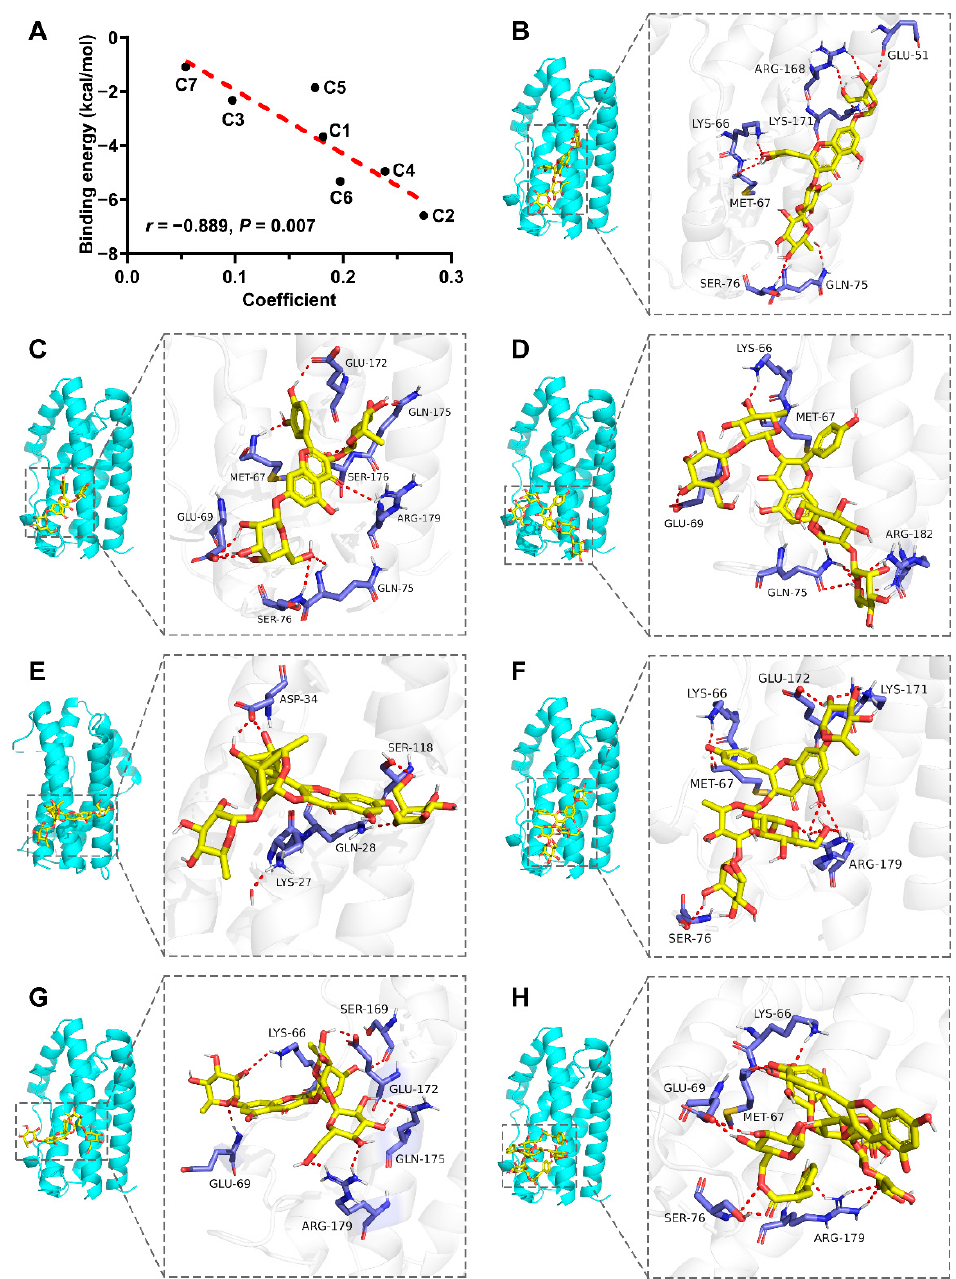
Figure 5. ( A ) Correlation analysis of the binding energy and the coefficient. ( B – H ) Docking patterns of the seven compounds and IL-6. ( B ) C1; ( C ) C2; ( D ) C3; ( E ) C4; ( F ) C5; ( G ) C6; ( H )